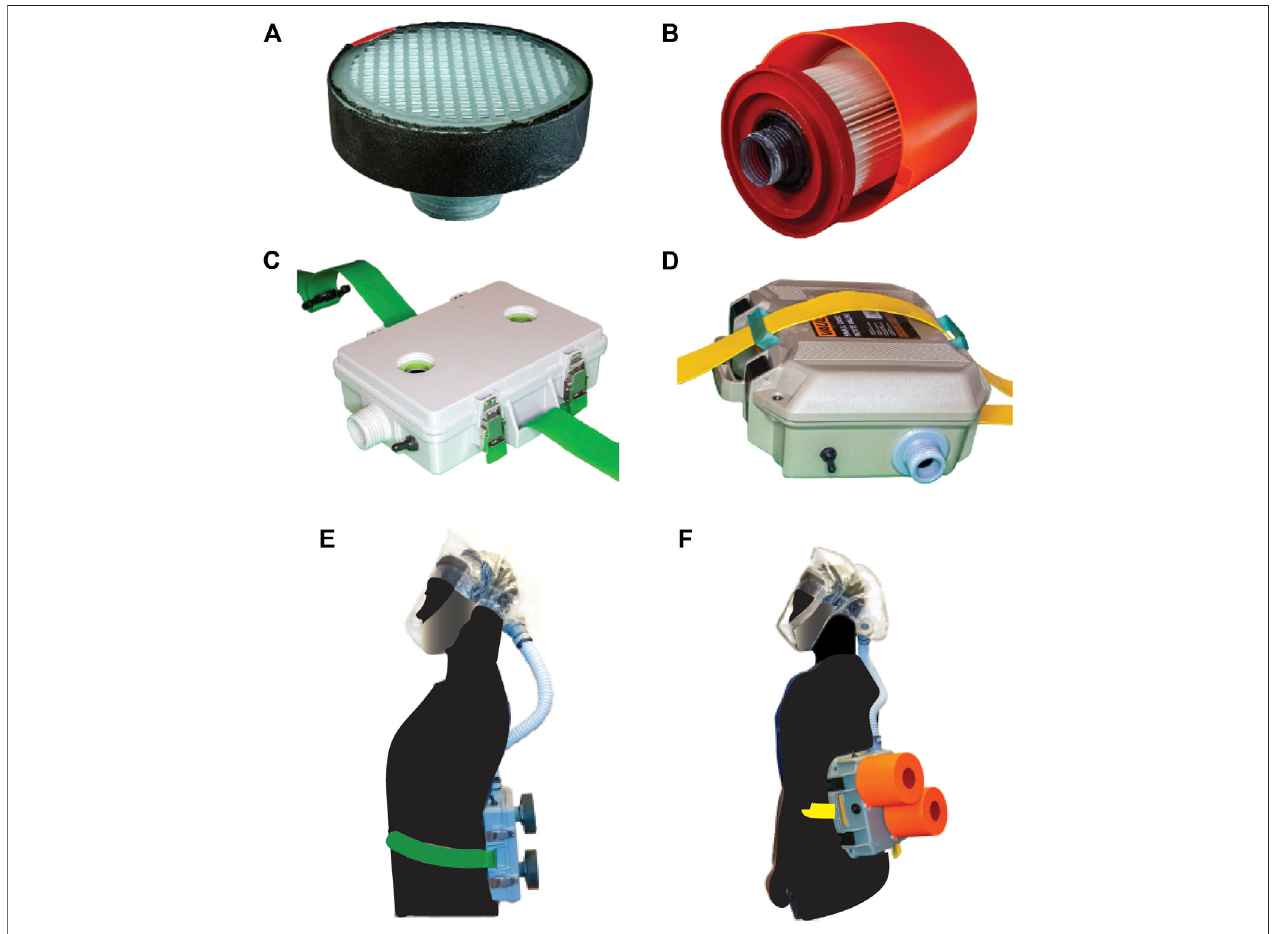
FIGURE 4 | PanFab PAPR components. (A) PanFab Custom fi lter cartridge. (B) PanFab Commercial fi lter cartridge. (C) PanFab Custom blower unit. (D) PanFab Commercial blower unit. (E) PanFab Custom Design (Custom fi lter cartridge plus Custom blower unit). (F) PanFab Commercial Design (Commercial fi lter cartridge plus Commercial blower